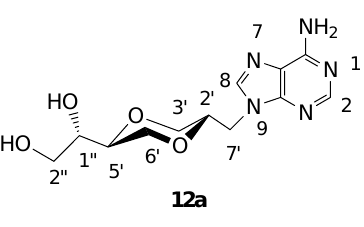
Figure 11. Structure 12a .